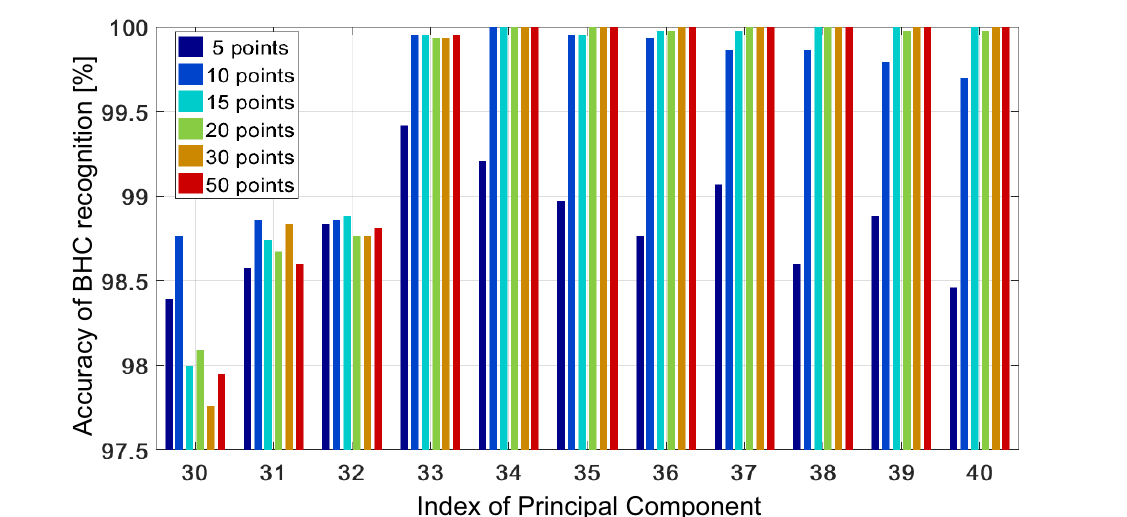
Figure 10. The accuracy of BHC recognition versus the number of PCs for various numbers of initialization points in the NM